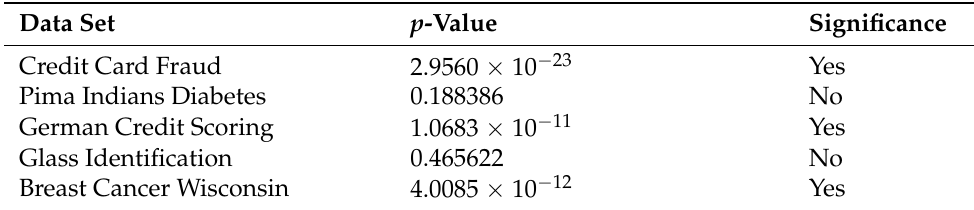
Table 9. Results for Friedman’s test.